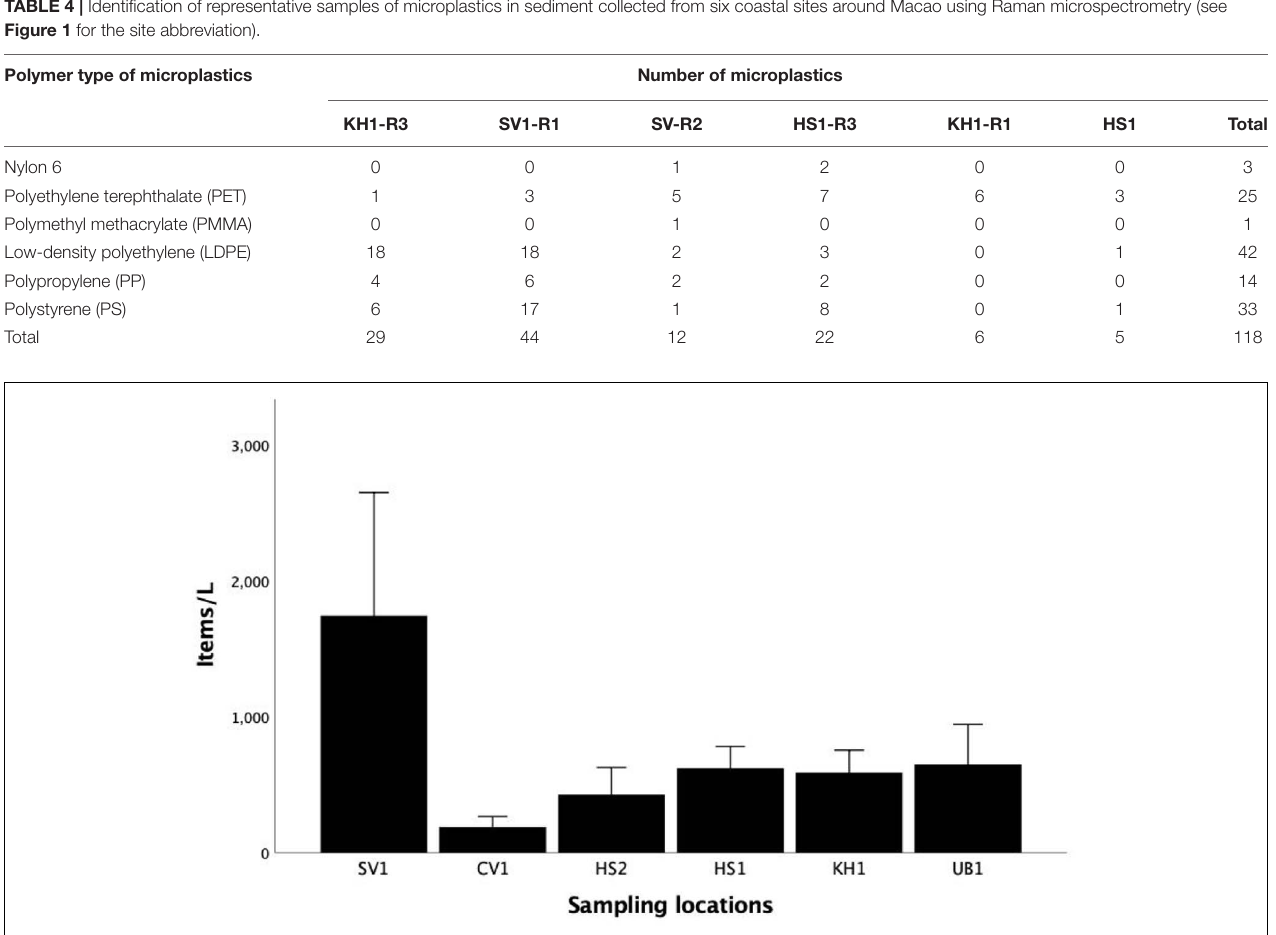
FIGURE 4 | Abundance of microplastics in sediment samples collected at six locations around Macao (mean + standard error of the mean; see Figure 1 for the site